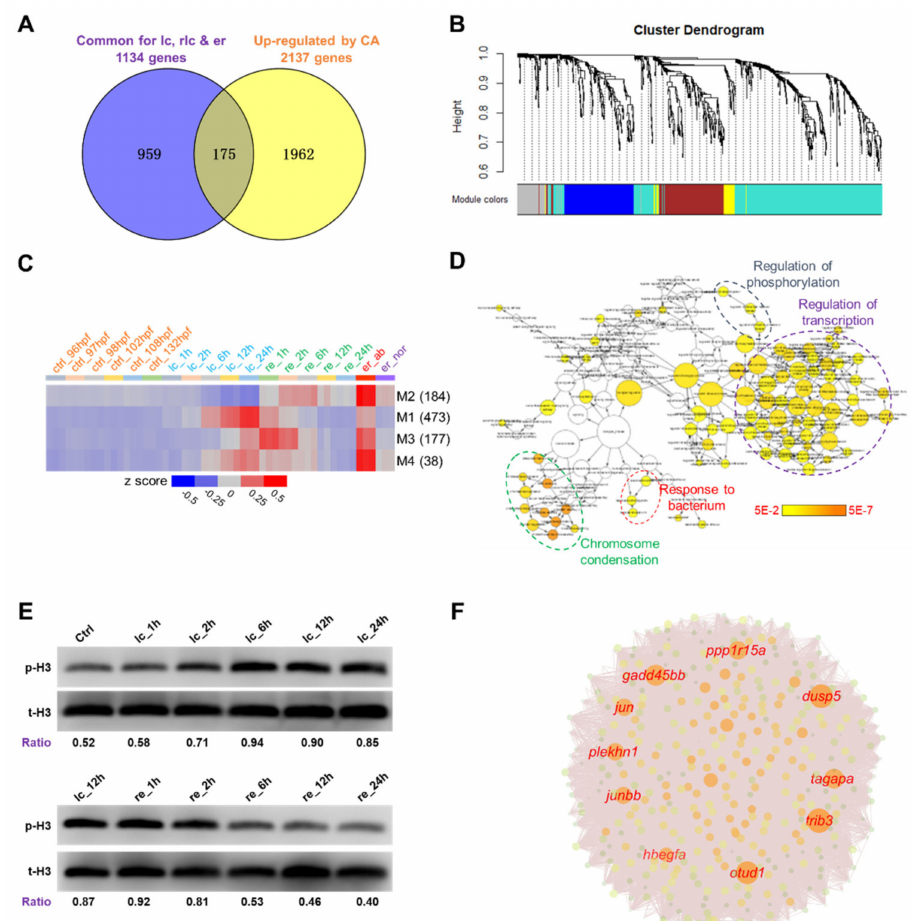
Figure 4. Identification of potential molecular markers for cold-induced damage. ( A ) Venn analysis to identify genes exclusively affected by exposure to lethal cold stress. The 1134 genes representing the intersection among DEGs affected by lc, re and er (Figure 2E) were compared with the 2137 genes previously found to be upregulated by 24-h acclimation to a mild low temperature (18 ◦ C) [17]. ( B ) Cluster dendrogram of the 959 genes exclusively related to lethal cold stress exposure. The genes were classified into 4 modules by WGCNA. ( C ) Heat map indicating eigengenes of the 4 modules. The number of genes in each module is shown on the right. The color scale indicates row z-score. ( D ) Enriched GO terms for the genes of module 1. The nodes represent GO terms and the edges indicate relationships between the nodes. Size of nodes is proportional to the number of genes associated with the term. The color scale indicates FDR (false discovery rate) of the enrichment analysis. ( E ) Western blots indicate changes in the level of phosphorylated histone H3 upon cold stress and during rewarming. Numbers below the blots are ratios of the phosphorylated histone H3 (p-H3) to total histone H3 (t-H3). ( F ) Network chart indicates hub genes of module 1. Names of the top 10 hub genes are highlighted. Size of the nodes is proportional to the maximal clique